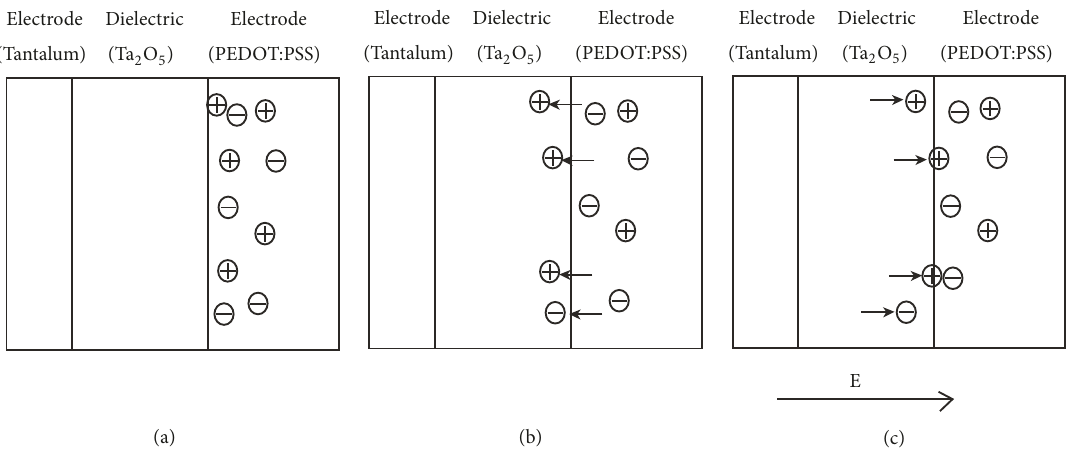
Figure 5: Interfacial polarization of tantalum capacitors with PEDOT:PSS